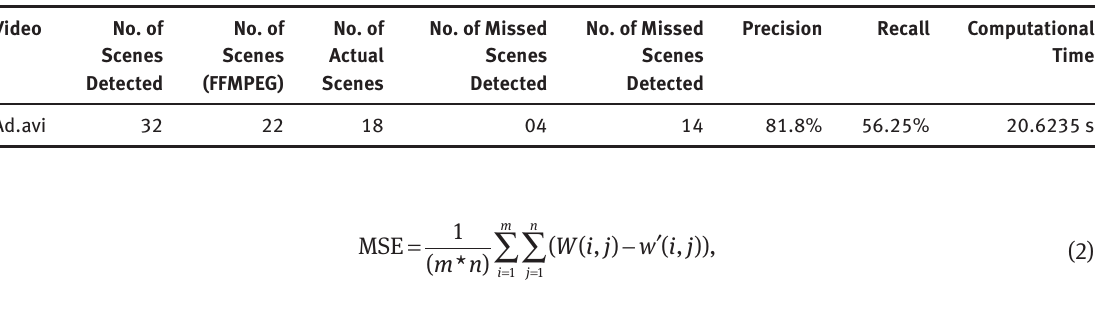
Table 1: Performance Evaluation of Scene Change Detector.